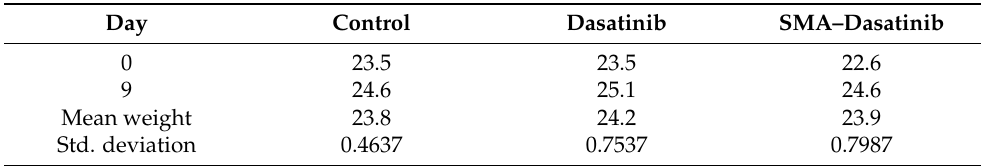
Table 3. Body weight changes upon treatment with dasatinib and SMA–dasatinib were monitored over the treatment period 1 .